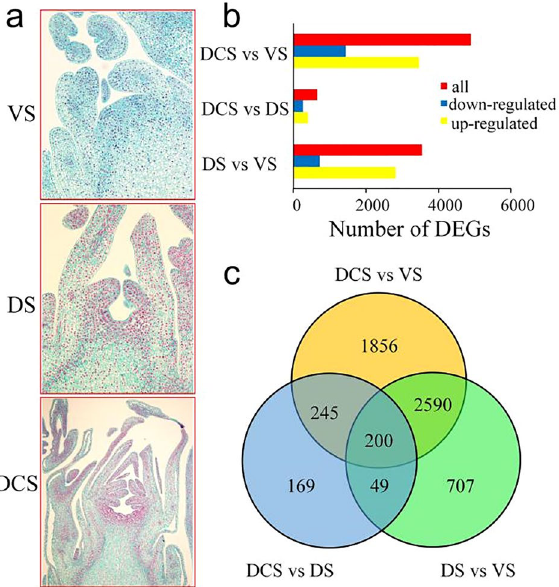
Figure 1. Analysis of the DEGs during the floral development in tree peony ’High Noon’. ( a ) The morphology of floral bud in ’High Noon’; VS, vegetative stage, DS, differentiation stage, DCS, differentiation completed stage; ( b ) The number of DEGs during bud development in ’High Noon’; ( c ) Venn diagram of DEGs involved in the phase change of floral development in tree peony ’High